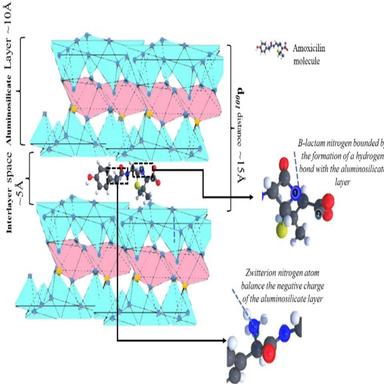
Schematic representation of the intercalation of AMO molecule in AMO1@BENT and AMO2@BENT materials.